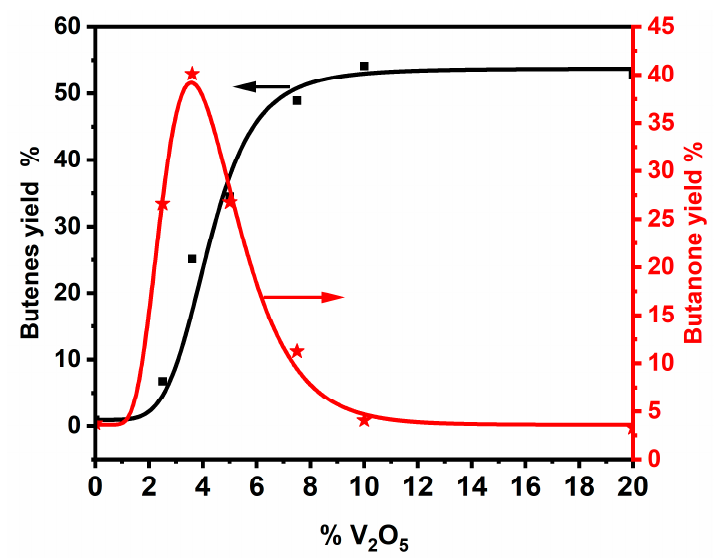
Figure 1. Evolution of the butenes and butanones yields at steady state depending on the V 2 O 5 con- tent (wt% = 2.5, 3.6, 7.5, 10, and 20) for a reaction mixture air + 2-butanol at 205 °C.